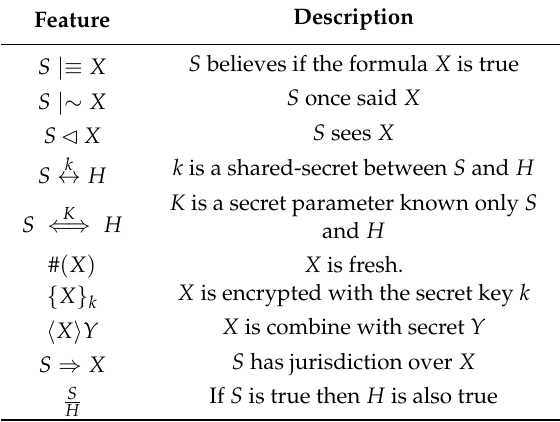
Table 2. Ban Logic notations.